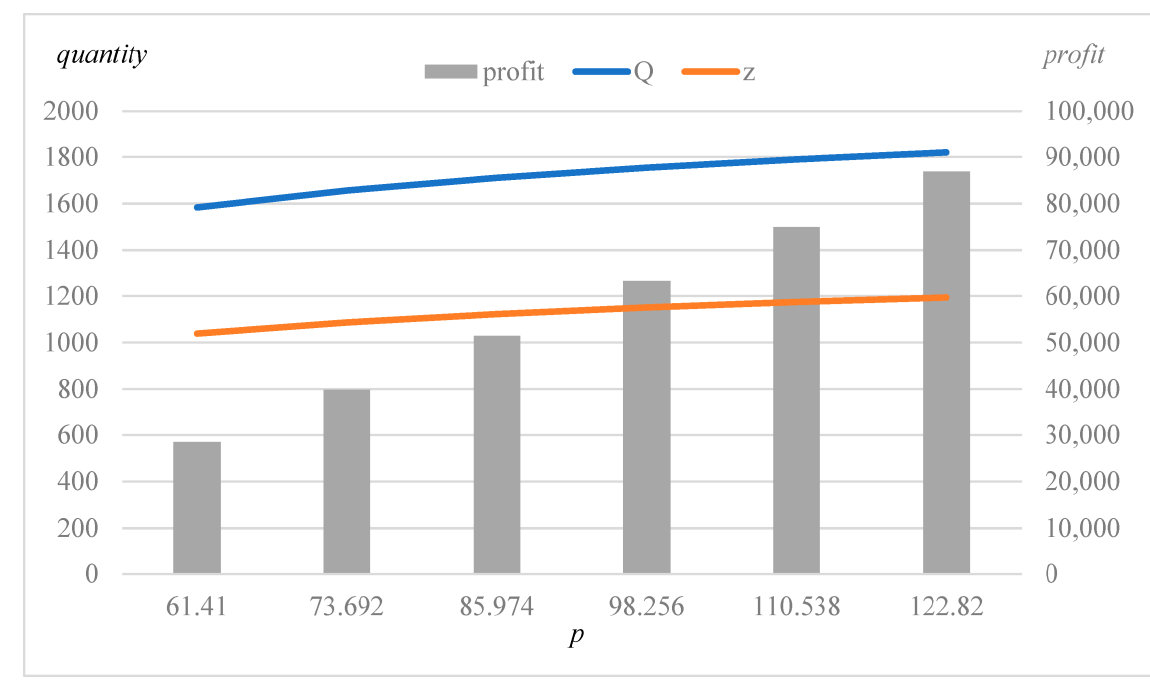
Figure 4. The results for various selling prices p .